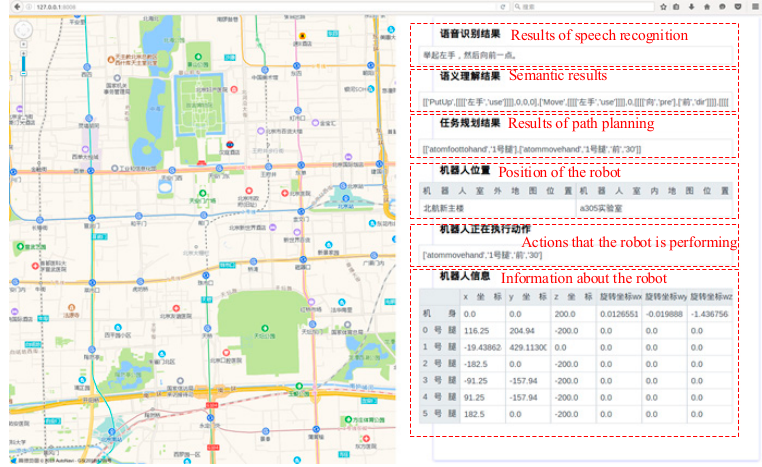
Figure 17. Graphical user interface of host computer.